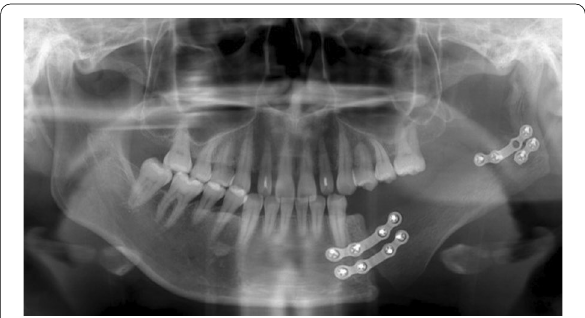
Fig. 1 Panoramic radiograph after segmental mandibulectomy and reconstruction Fig. 2 Intraoral view before prosthetic